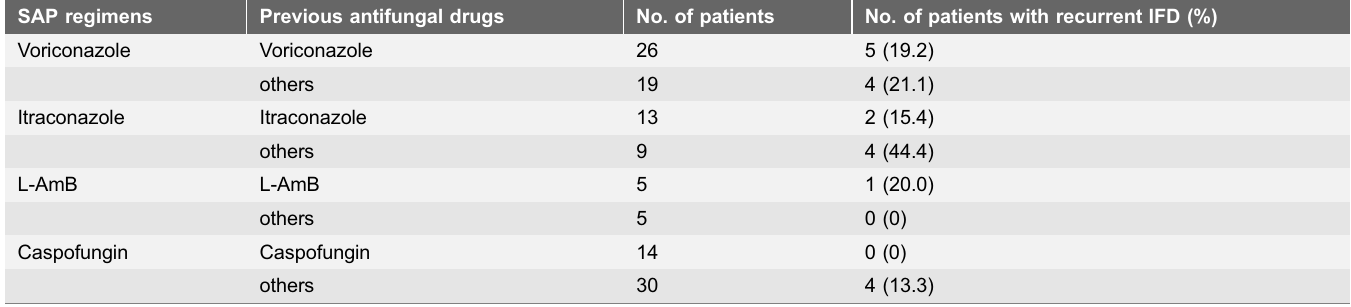
Table 4. Treatment of previous IFD, SAP regimens, and IFD